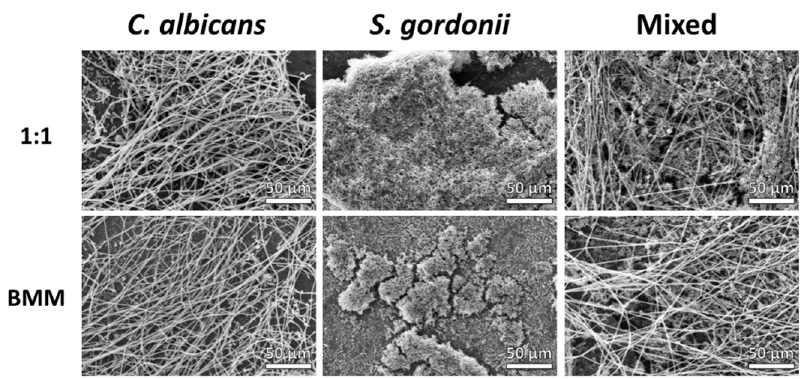
Figure 2. SEM micrographs of C. albicans and S. gordonii single- and dual-species biofilms grown in 1:1 v / v RPMI/THB + 0.02% YE media (upper panel) and BMM synthetic saliva (lower panel) formed on titanium discs. Magnification ×500.